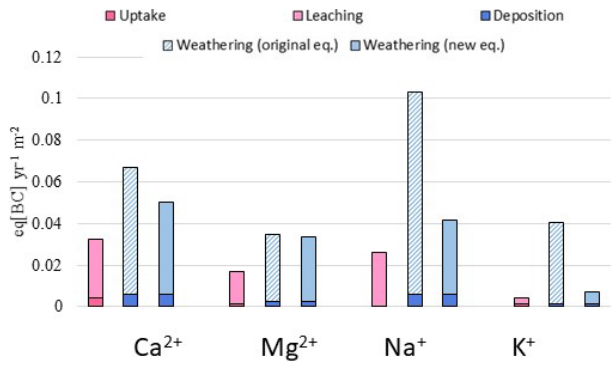
Figure 8. Sinks and source terms of the base cation mass bal- ance for a hillslope. The first bar (pink) represents sink terms (net tree uptake and runoff), the second bar represents the source terms with weathering calculated from the original PROFILE equations (model 1) and the third bar represents the source terms with weath- ering calculated from the new PROFILE equations (model 3).